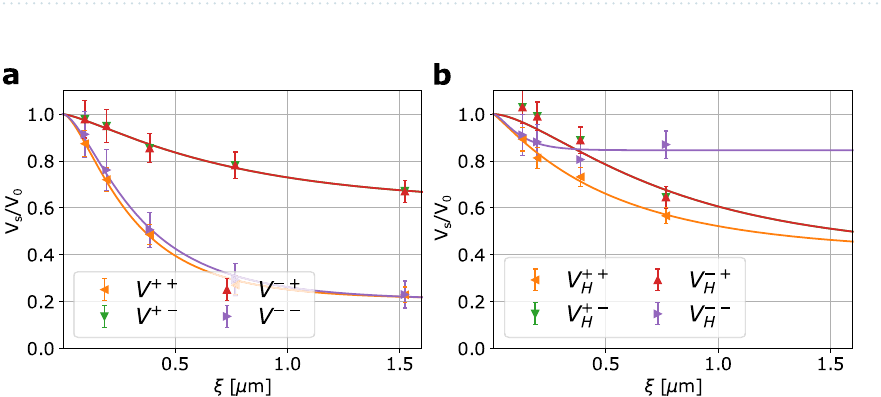
Figure 4. Measured polarized DFI of the sintered NdFeB magnet. (a) TI and DFI images of the NdFeB with and without the external magnetic field at ξ ≃ 0.7 µ m and without analyzer in place. The North and the South poles of the applied field are depicted in red and blue, respectively. (b) DFI experimental values and the fitted V s (ξ) G (ξ) for the four configurations without the external V 0 curves based on model of correlation functions magnetic field corresponding to the V ++ , V −+ , V + and V − . (c) DFI experimental values and the fitted DFI curves with the extracted correlation functions G (ξ) for the four configurations with the external magnetic field corresponding to the V ++ H , V −+ H , V + H and V − H . The modeled G (ξ) functions were based on the description of random two phase media. The magnetization easy axis of the sample is along the short side of the sample and along the applied external magnetic field.